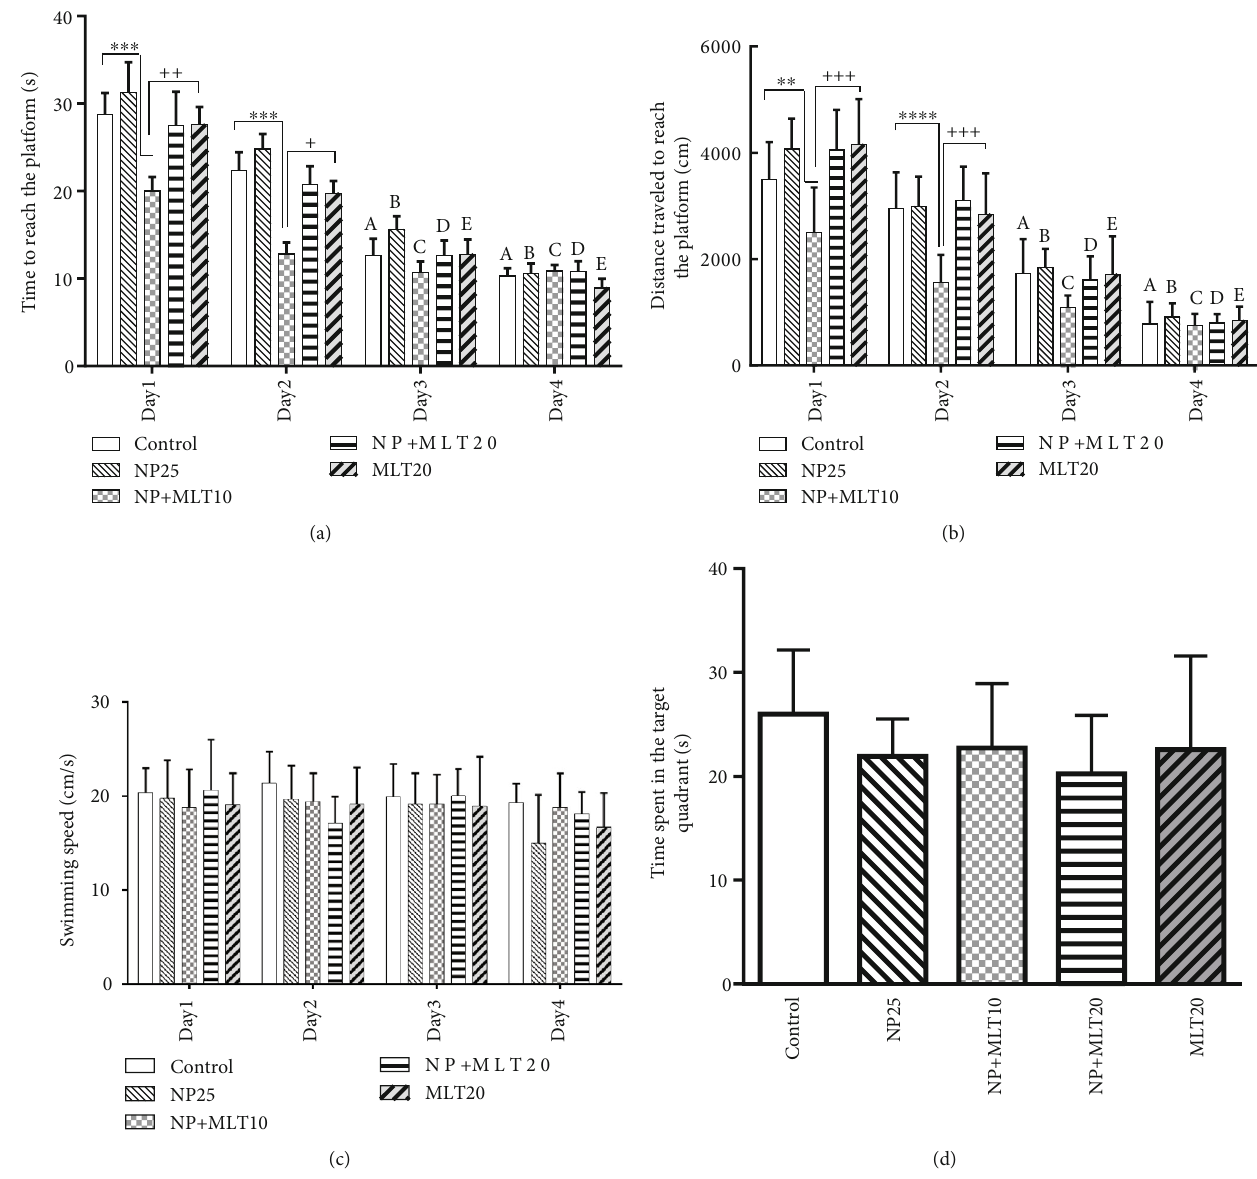
Figure 1: NP did not a ff ect learning and memory in the fi rst generation of adult rats but MLT improved learning. Comparison of mean (a) escape latency, (b) distance traveled to reach the platform, (c) swimming speed from day 1 to day 4 of training trial, and (d) time spent in the target quadrant in the probe trial in the Morris water maze test. A, B, C, D, and E: comparison within groups. ∗∗∗∗ p < 0 : 0001 , ∗∗∗ p < 0 : 001 , ∗∗ p < 0 : 01 , and ∗ p < 0 : 05 : comparison in between groups. Data from training trials were analyzed by repeated measure two – way ANOVA and probe test with one-way ANOVA coupled with Tukey post hoc test. Data are presented as means ± SD for eight animals in each